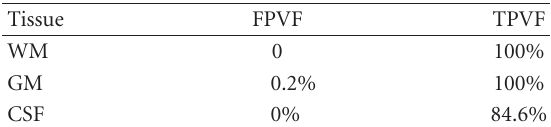
Table 1: Error measurements for the segmentation of the brain